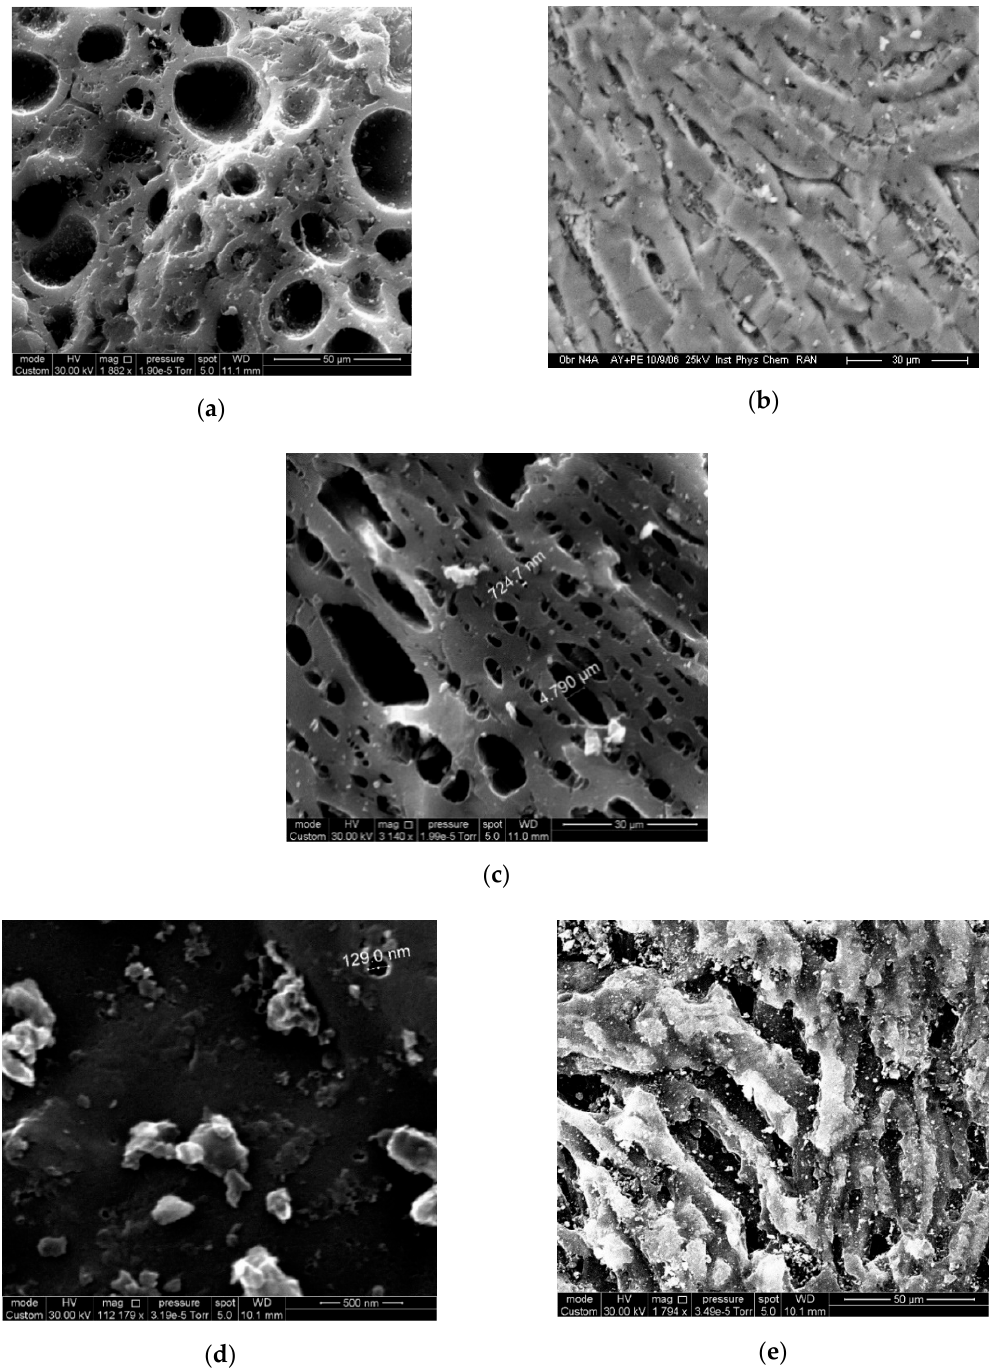
Figure 5. Scanning electron microscopy (SEM) images of transverse ( a , c , d ) and longitudinal ( b , e ) sections of the CNS-derived carbons with the different burn-off degree: AC-90S ( a , b ); AC-90L ( c ), and AC-60L ( d , e ). Note the difference in scale bars.